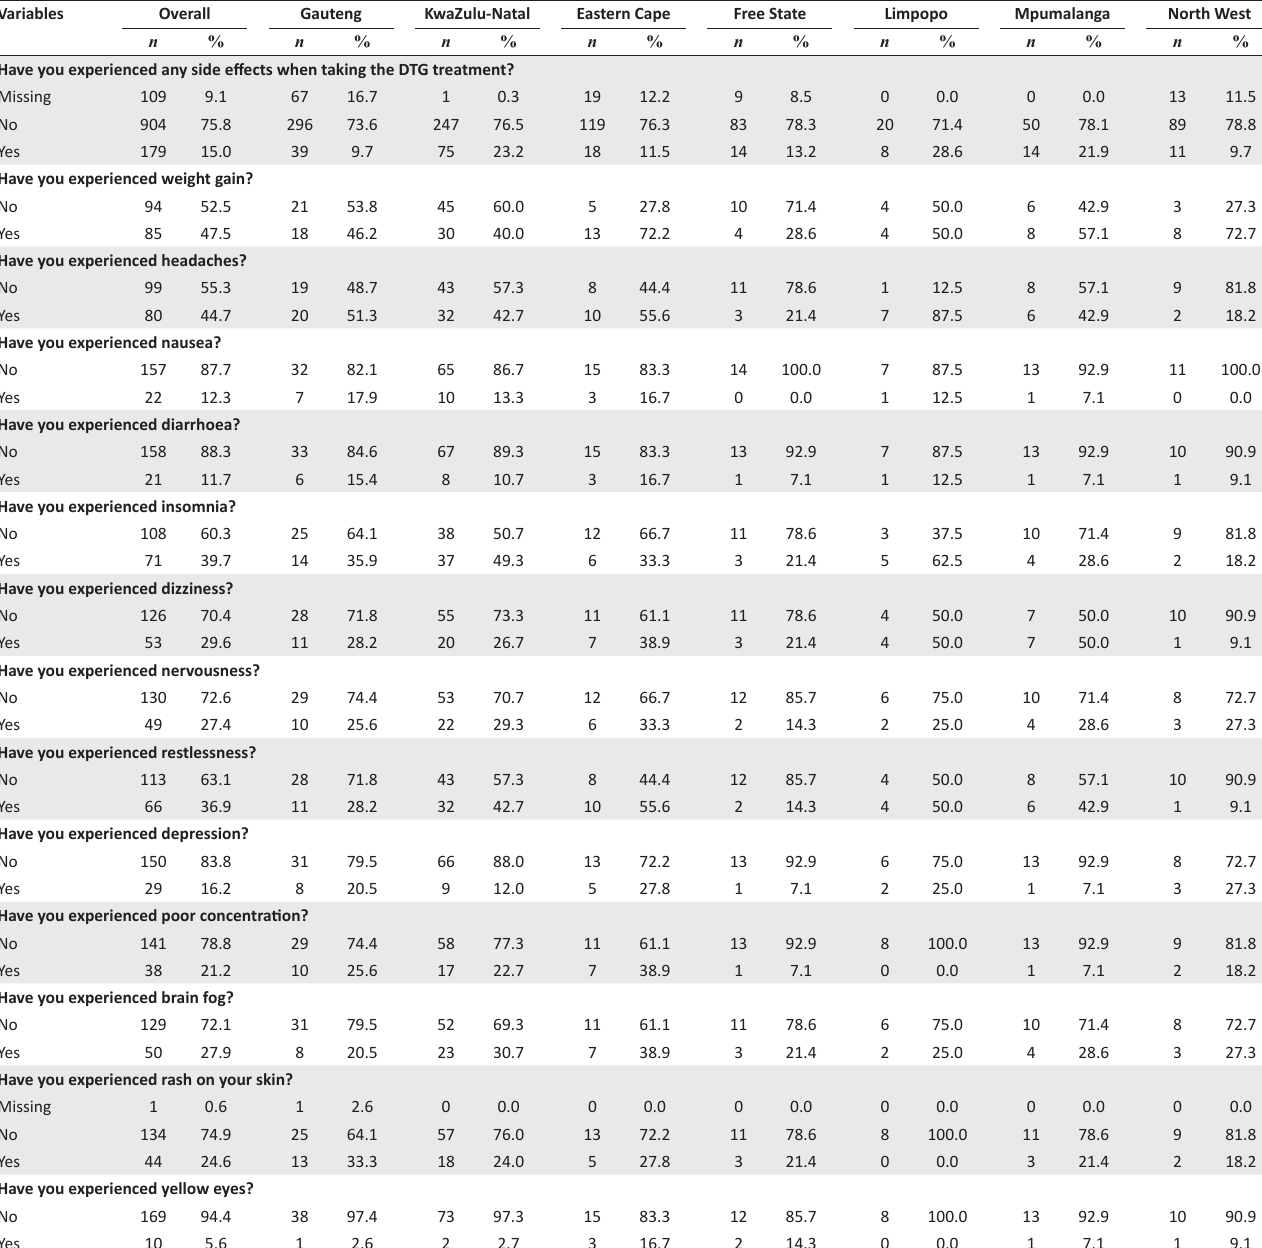
TABLE 2: Adverse drug reactions reported by patients on the tenofovir disoproxil fumarate/lamivudine/dolutegravir regimen in the survey.